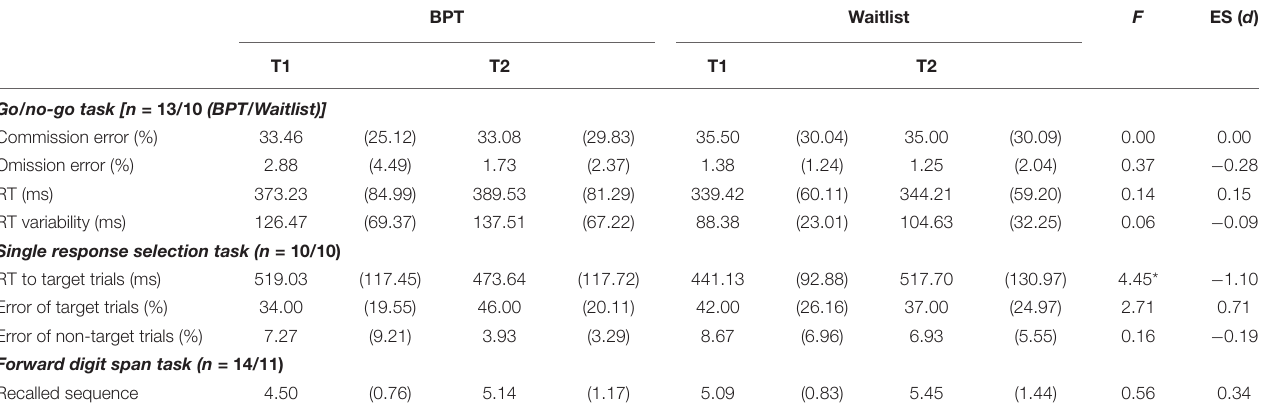
TABLE 3 | Objective cognitive task outcomes for the BPT and waitlist control groups. BPT Waitlist